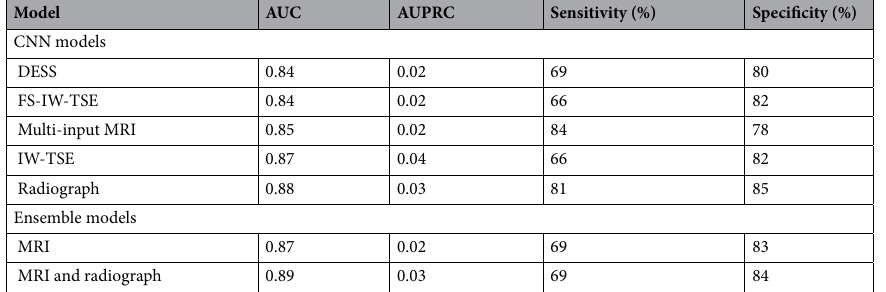
Table 3. Receiver operator characteristic analysis with areas under the curve (AUC) and area under the precision-recall curve (AUPRC) evaluating the diagnostic performance of the models to predict total knee replacement (TKR) using the internal hold-out testing group in the OAI database for all knees combined. 3D Three-dimensional, CNN Convolutional neural network, CI Confidence interval, DESS Sagittal